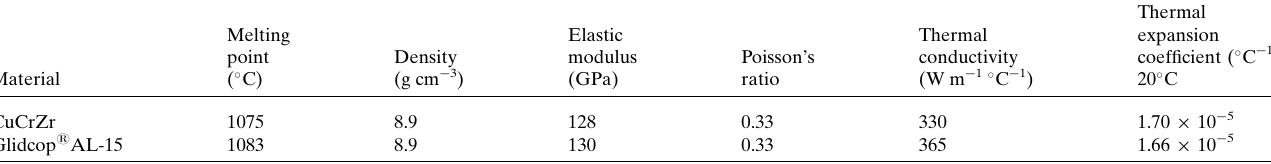
Table 1 Physical properties of CuCrZr and Glidcop 1 AL-15.